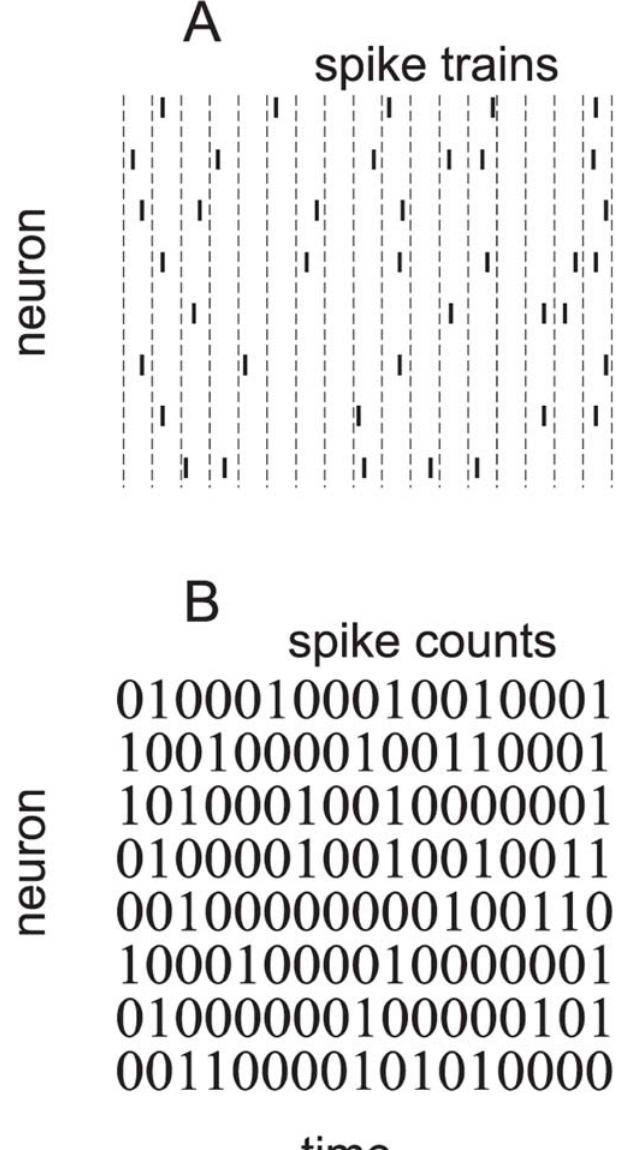
Figure 1. Transforming spike trains to spike count. (A) Spike rasters. Tick marks indicate spike times; different rows correspond to different neurons. The horizontal dashed lines are the bin boundaries. (B) Spike count in each bin. In this example the bins are small enough that there is at most one spike per bin, but this is not necessary—one could use bigger bins and have larger spike counts.